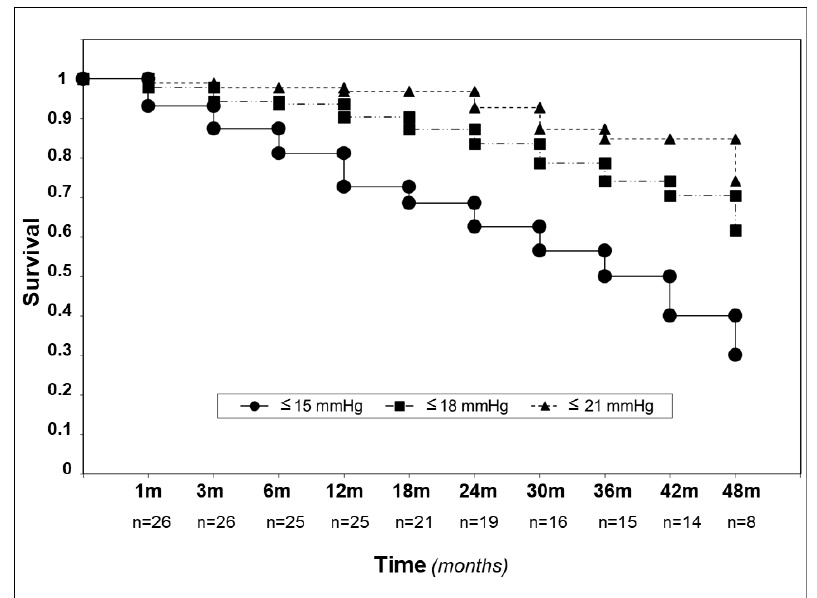
Figure 4. Kaplan–Meier graph according to three different endpoints (IOP ≤ 21, 18, and 15 mm/Hg). The complete and qualified (in brackets) success rate—defined as an IOP ≤ 21 mmHg—after 1,